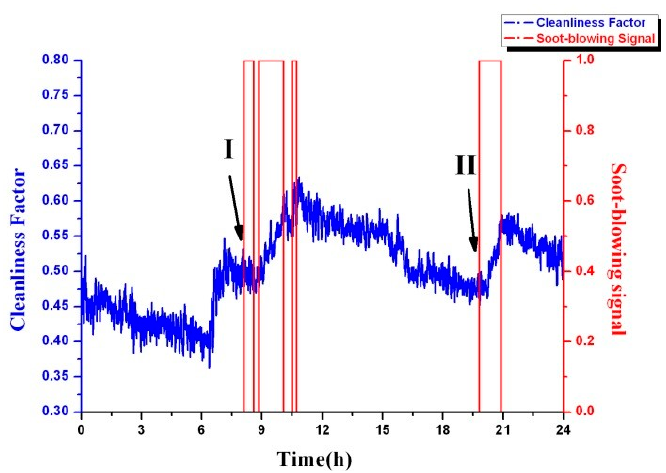
Figure 1. Monitoring results: economizer cleanliness factor versus soot ‐ blowing signal.